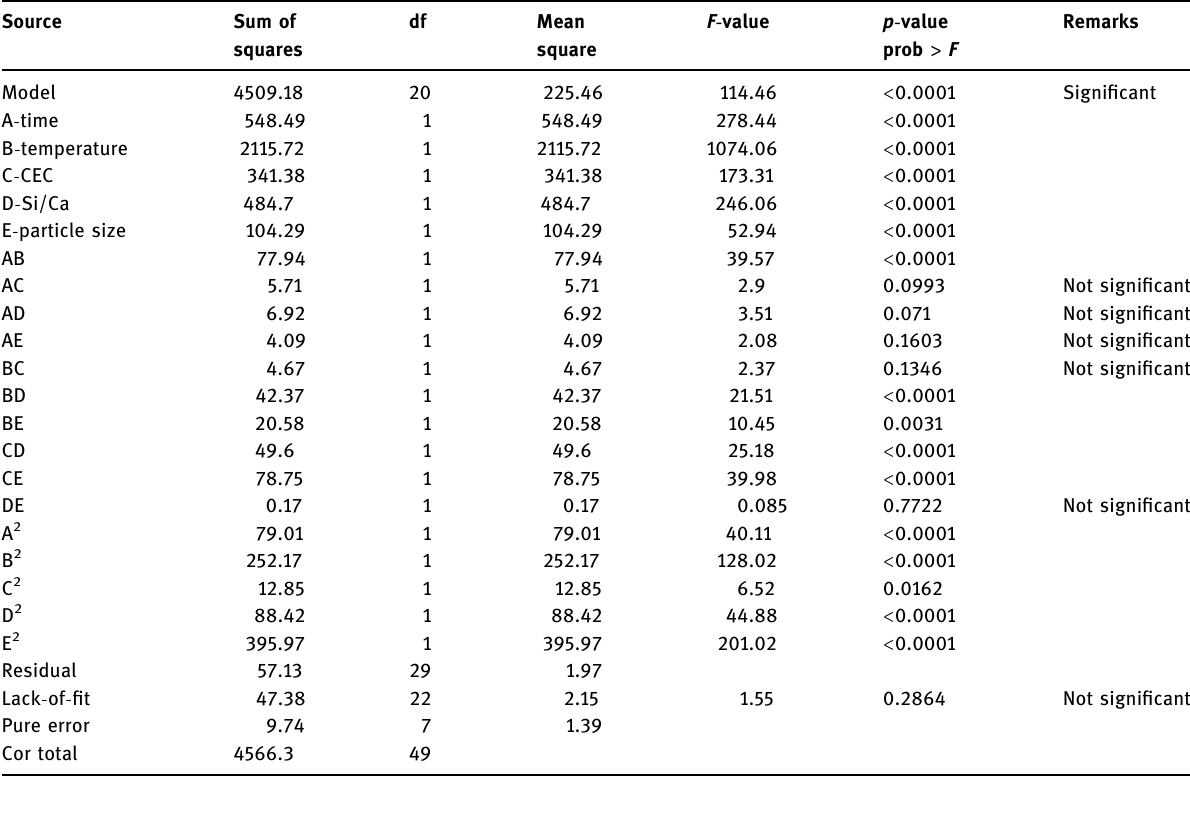
Table 6: Analysis of variance for the regression model Source